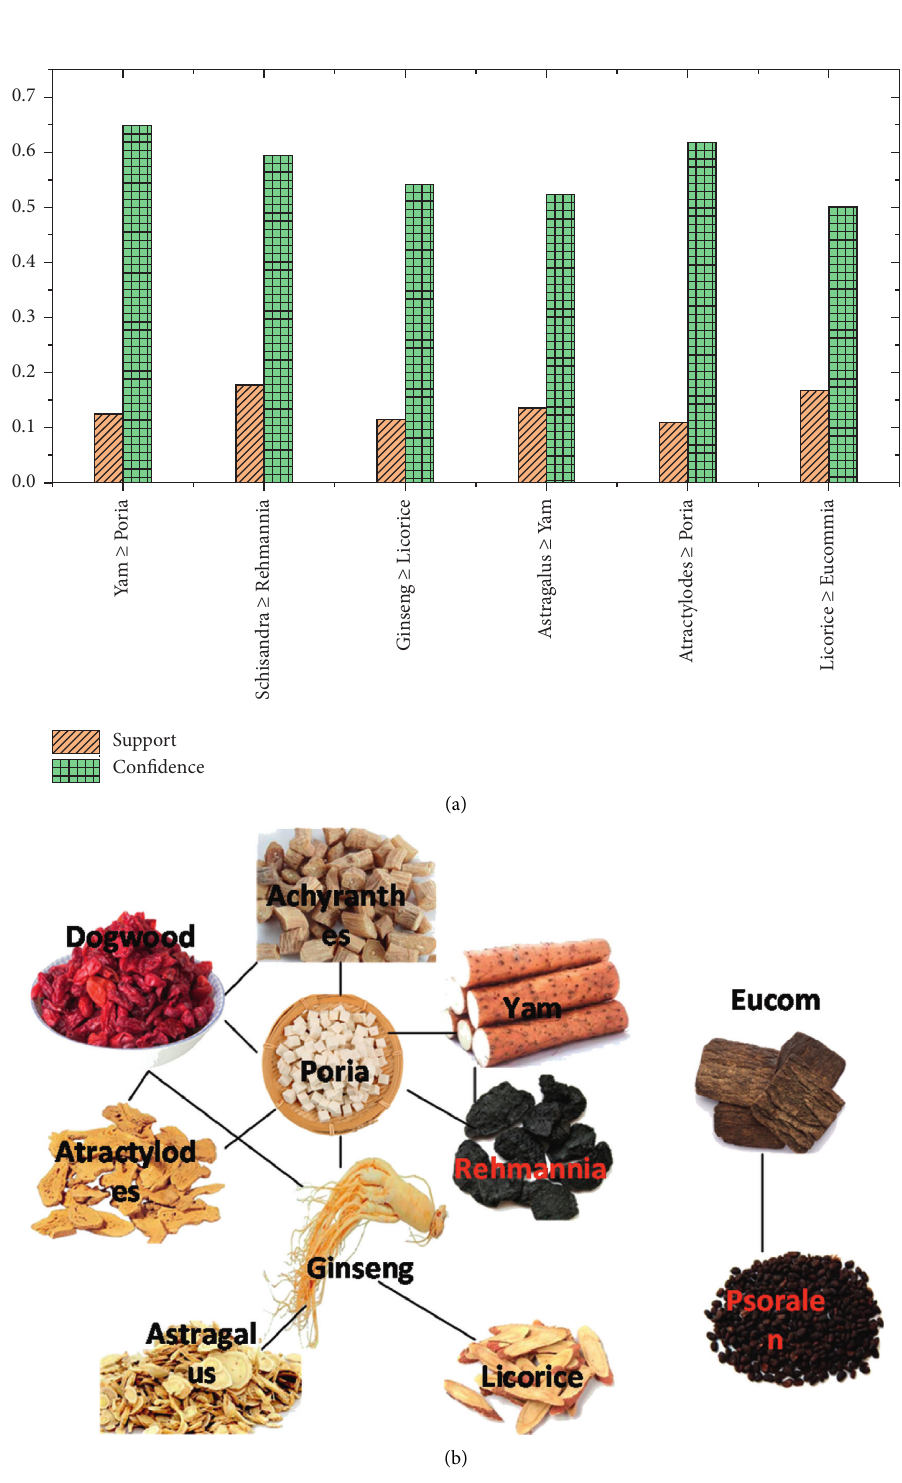
Figure 8: Analysis results and display of association rules of Chinese medicine. (a) The results of the mining. (b) Visualization of the drugs in the strong association